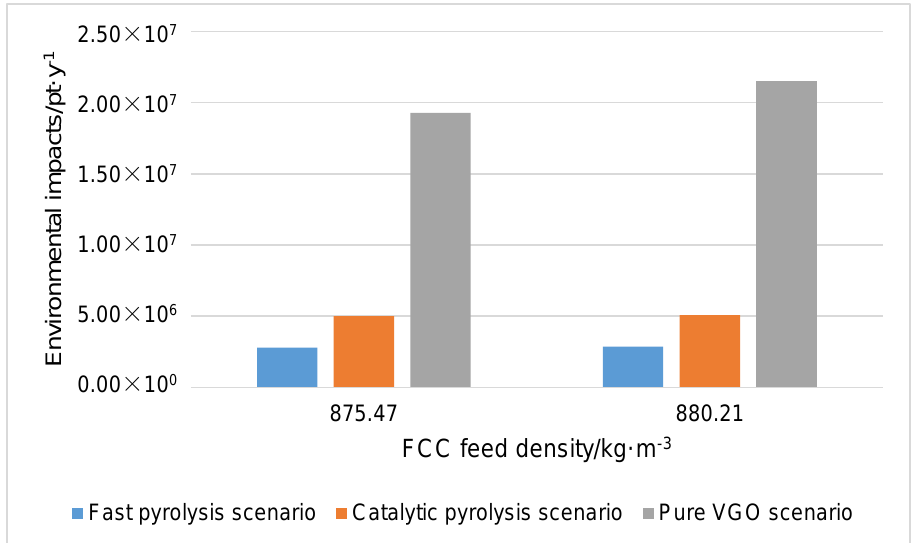
Figure 8. Effect of FCC operating temperature on environmental impacts.